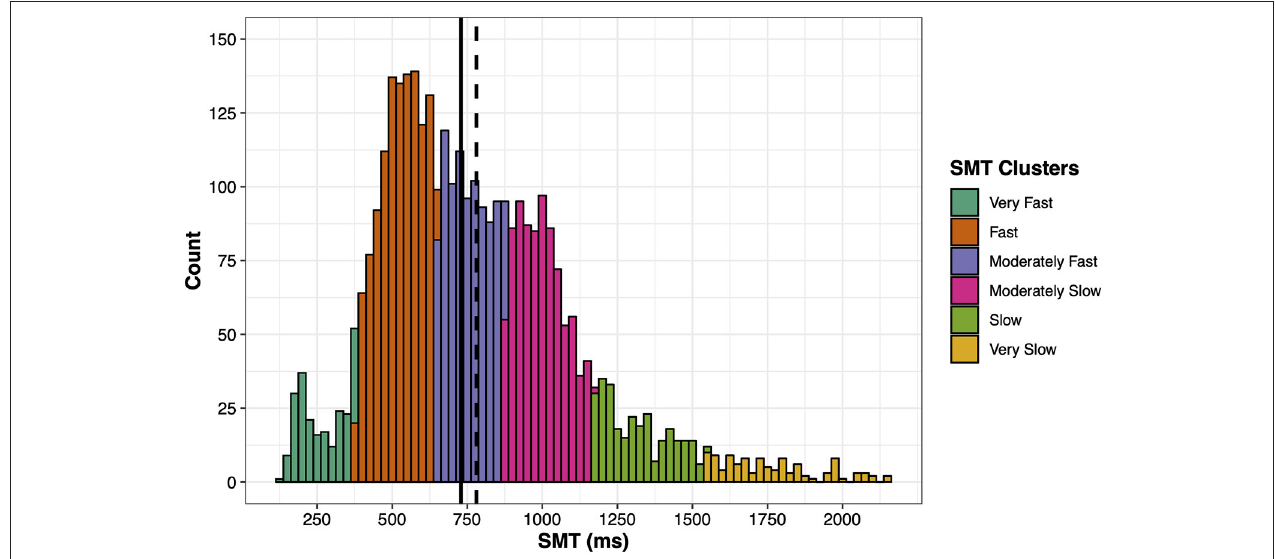
FIGURE 1 | Distribution of the SMT data. The solid line indicates the median and the dashed line the mean. Each color represents a SMT cluster. The bar width represents